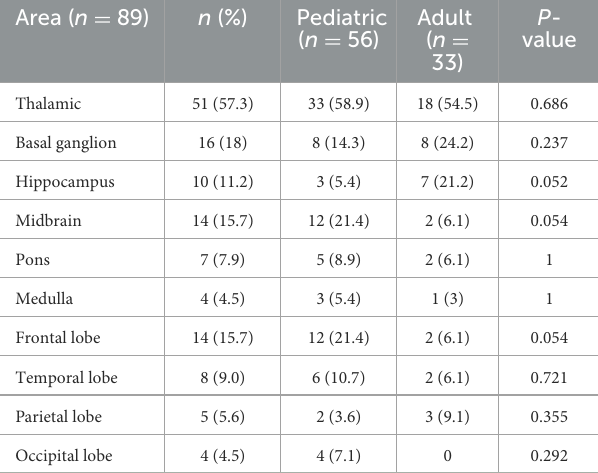
TABLE 4 MRI findings of pediatric and adult patients with